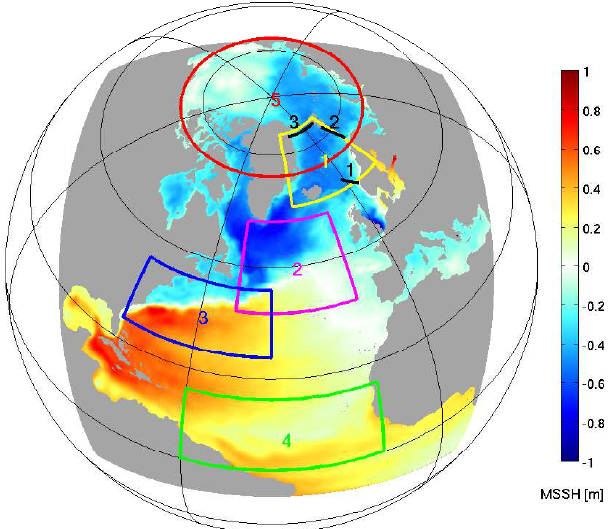
Fig. 1. TOPAZ model domain. The background colour shows the mean sea surface height computed from a free model run over the period 1993–1999; the grey colour shows land; the numbered boxes show regions used for calculating innovation statistics for the re- analysis (see Table 2); and the black lines show the sections used for volume transport and temperature validation: Svinoy section (1); Barents Sea Opening section (2); and Fram Strait section (3).